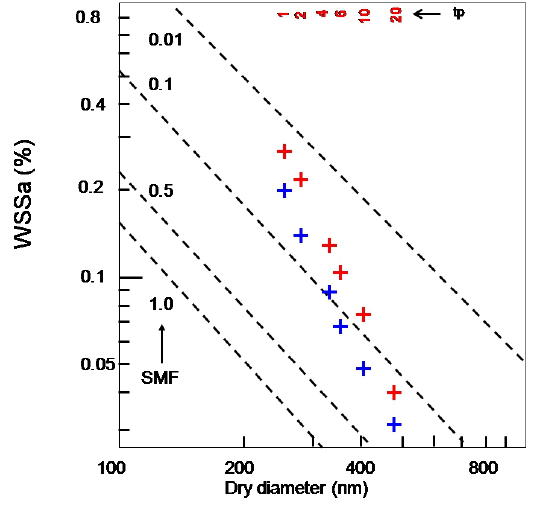
Fig. 12. Critical water vapor supersaturation WSSa as function of aerosol particle dry diameter (nm) for different NH 4 NO 3 soluble mass fractions (SMF = 0.01, 0.1, 0.5, 1.0) (adopted from Seinfeld and Pandis, 1998). The crosses denote modeled WSSa as function of modeled diameters and H 2 SO 4 -mass fractions of smoke parti- cles, for six time steps tp (1, 2, 4, 6, 10, 24 days) for the plume parcel intercepted on 13 August 2006 at 3900m altitude. H 2 SO 4 only: red cross; H 2 SO 4 +NH 4 NO 3 : blue